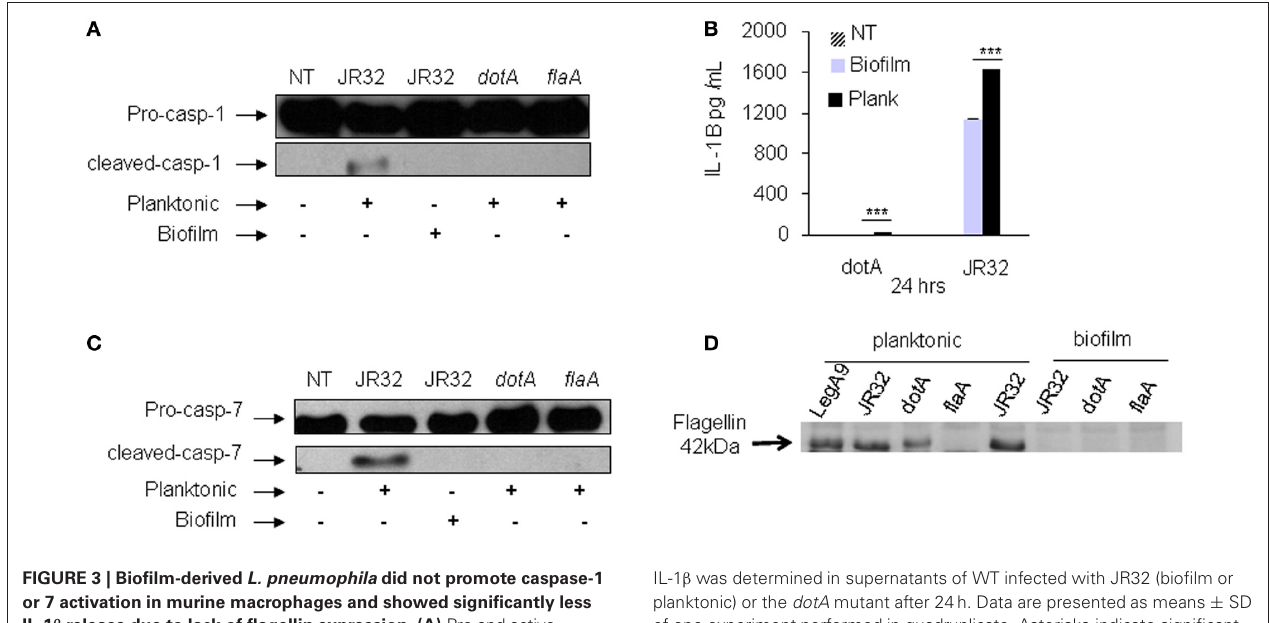
IL-1 β was determined in supernatants of WT infected with JR32 (biofilm or planktonic) or the dotA mutant after 24h. Data are presented as means ± SD of one experiment performed in quadruplicate. Asterisks indicate significant differences ( ∗∗∗ P < 0 . 001). (C) Activation of caspase-7 was detected in cell extracts using caspase-7 antibody. (D) Western blot analysis of planktonic and biofilm-derived L. pneumophila with flagellin